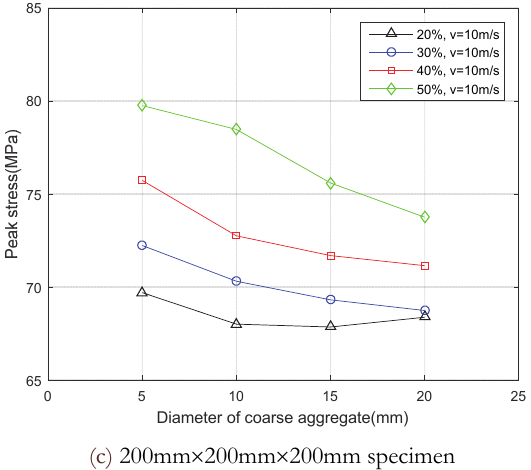
Figure 7: Relationship between minimum aggregate particle size and peak stress of